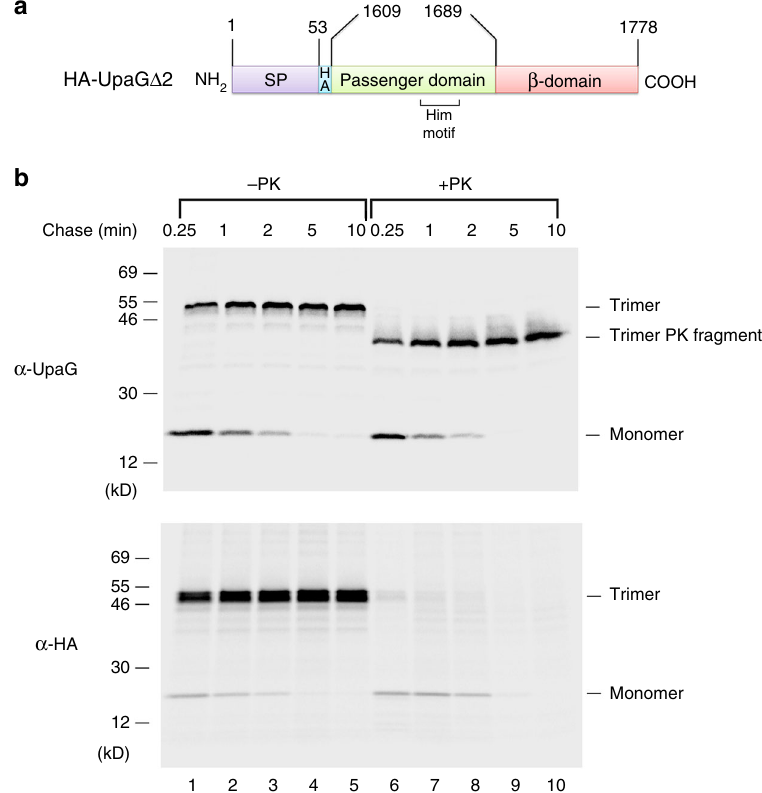
Fig. 1 A model TAA assembles rapidly. a Illustration of HA-UpaG Δ 2, an HA-tagged derivative of UpaG that contains the C-terminal 170 residues of the protein. The signal peptide (SP) (residues 1 – 53 of the full-length protein), the passenger-domain fragment (residues 1609 – 1689) and the segment that trimerizes to form the β -domain (residues 1689 – 1778) are indicated. A predicted Him motif (residues 1655 – 1675) is also shown. An HA tag was inserted at the N terminus of the passenger domain. b AD202 transformed with pRS1 (P trc - HA-upaG Δ 2 ) were subjected to pulse-chase labeling. Half of the cells were treated with PK, and immunoprecipitations were performed using an anti-UpaG or an anti-HA